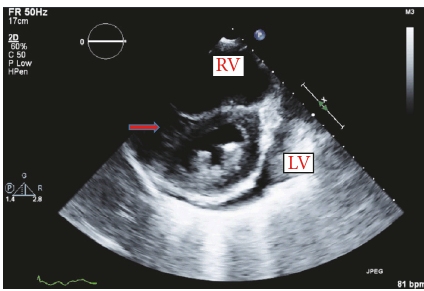
Figure 2: Transthoracic echocardiogram 2D during end-diastolic phase, after hemodialysis showing improvement of flattening (red arrow) of the interventricular septum (D-shaped left ventricle) and displacement toward left ventricle (LV). Right ventricle